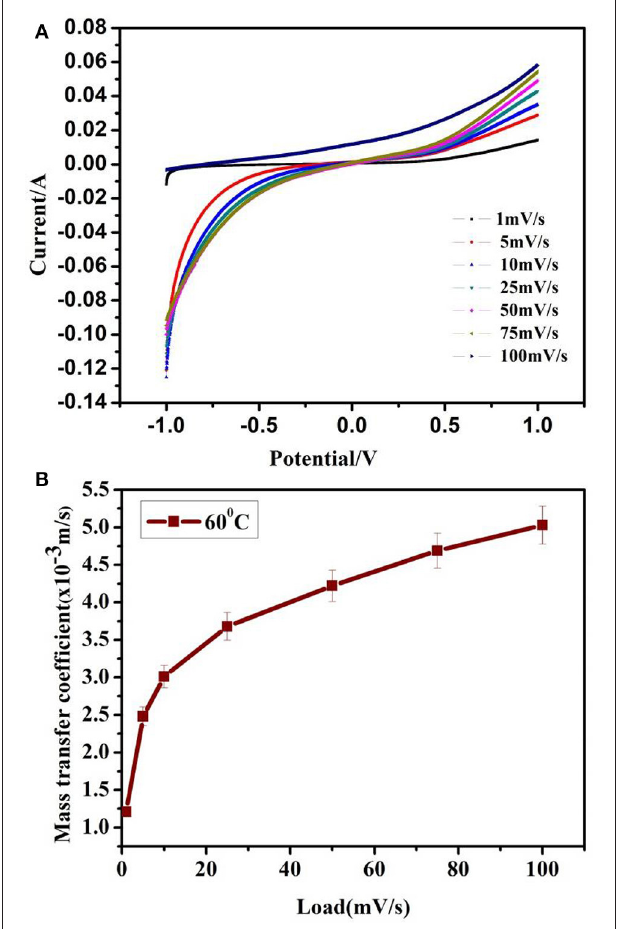
FIGURE 2 | (A) Linear sweep voltammetry of the device at 1 T = 60 ◦ C. (B) Mass transfer coefficient of the device at 1 T = 60 ◦ C (an error accounting for 5% error in mass transfer coefficient values calculated by assuming maximum current to be limiting current in LSV).